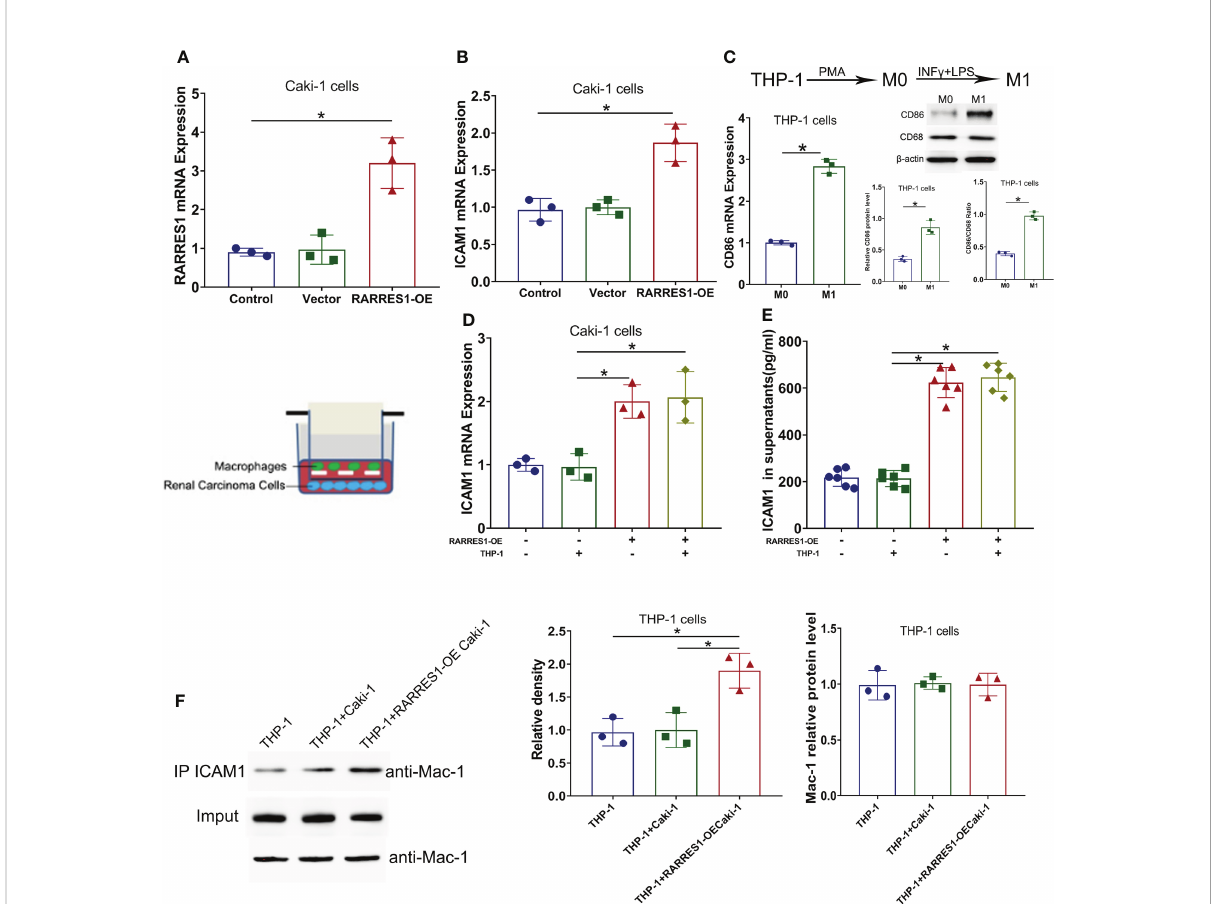
FIGURE 6 ICAM1 expression and interaction with Mac-1 were induced by RARRES1 overexpression. (A, B) Relative RARRES1 (A) and ICAM1 (B) mRNA expression in renal carcinoma cells, as measured by qPCR after transfection. RARRES1 and ICAM1 were signi fi cantly upregulated in the RARRES1-OE group; *p < 0.05 compared to the vector group; n = 3 in each group. (C) CD86 mRNA and protein expression in THP-1 cells after stimulation with IFN- g . *p < 0.05 compared to the THP-1 only group. (D) ICAM1 mRNA expression in RCC cells cocultured with macrophages. Coculture of RARRES1-overexpressing RCC cells with macrophages induced evident upregulation of ICAM1 in RCC cells. *p < 0.05 (E) The level of ICAM1 in cell supernatants was measured by ELISA and was signi fi cantly increased after RARRES1 overexpression in RCC cells. *p < 0.05 (F) The Co-IP assay showed that overexpression of RARRES1 in RCC cells signi fi cantly promoted the interaction of ICAM1 and Mac-1. *p <